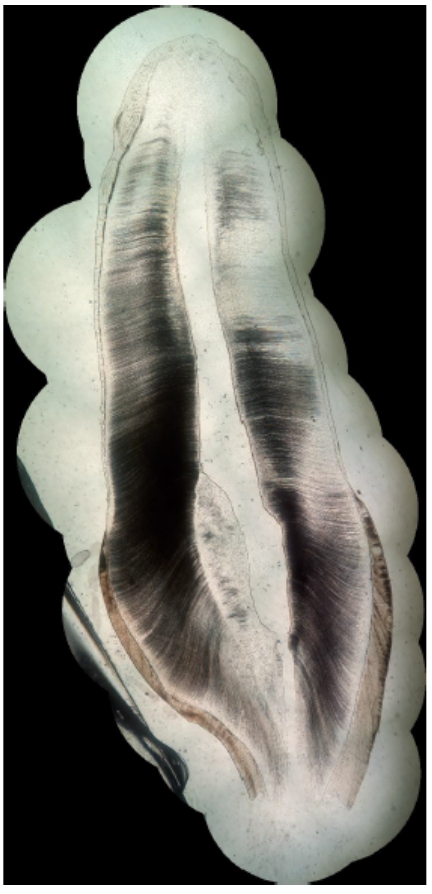
Figure 6. A second example of high-resolution stitched picture of a sagittal cross-section of a permanent maxillary central